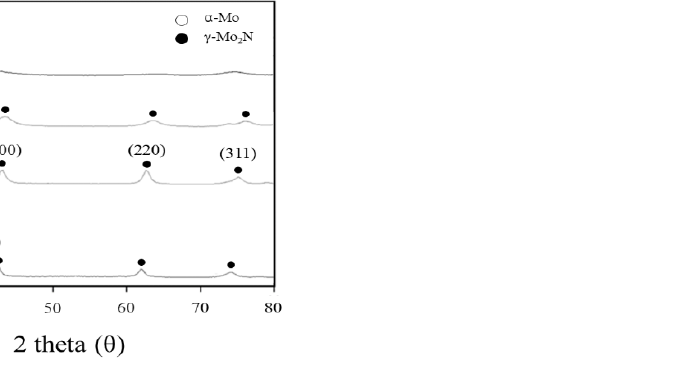
Figure 1. XRD pattern of MoN coating deposited by ICP powers ( a ) 0 W, ( b ) 50 W, ( c ) 100 W, ( d ) 200 W. Table 1. XRD data of MoN coatings for ICP assisted sputtering.